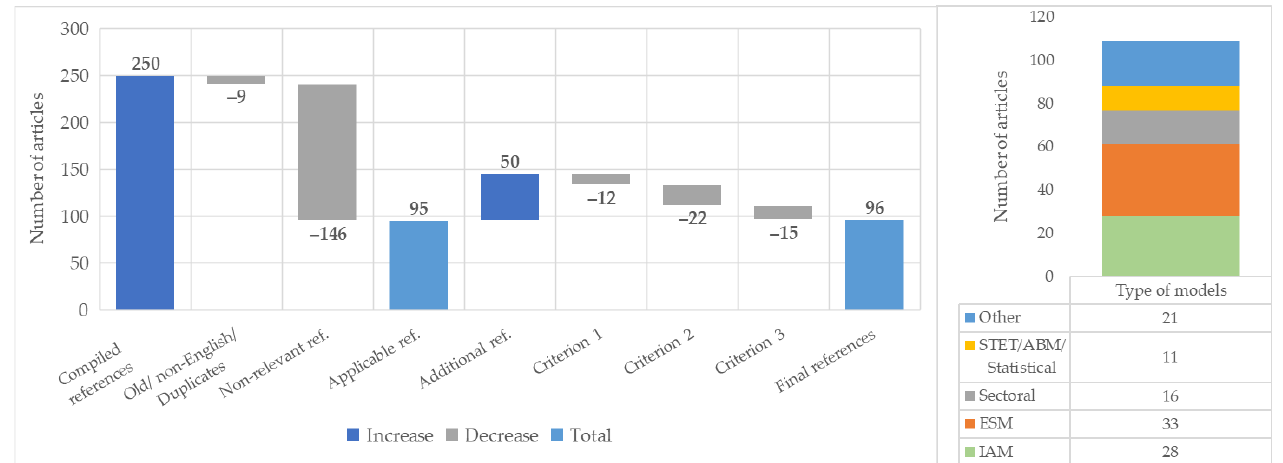
Figure 2. Reference selection and filtering process broken down to individual stages of the literature search. Selected studies are split according to the type of model used in the investigation. Note: Totals in the column chart are higher than the number of selected papers as some studies use more than one type of model.